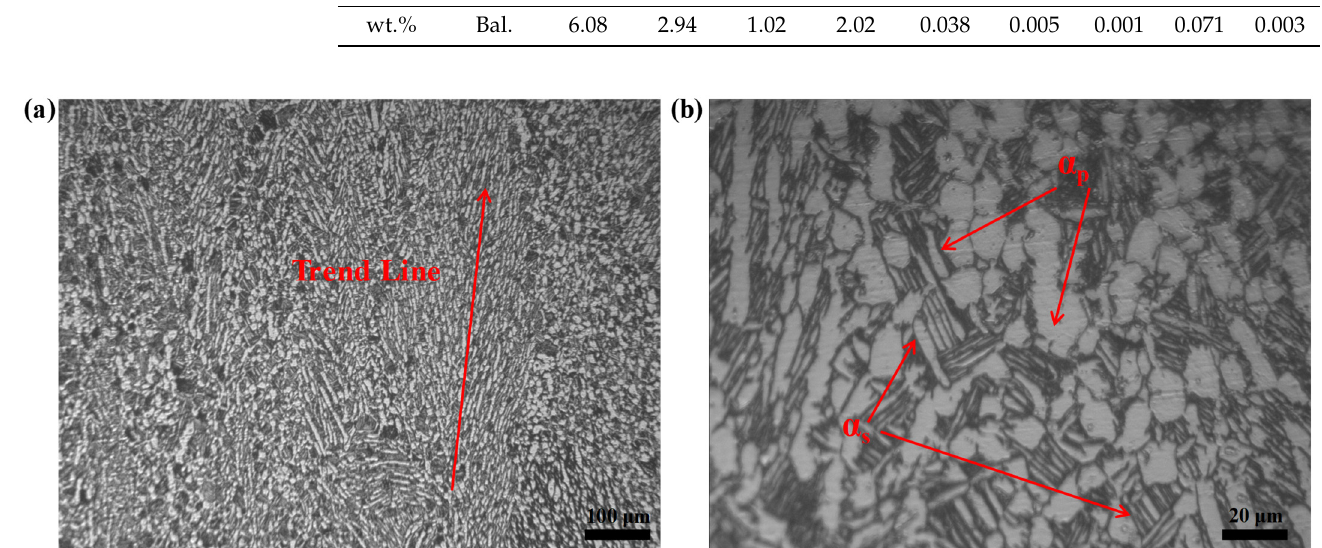
Figure 1. Initial microstructure of TA31 in the as-received condition: ( a ) 100×; ( b ) 500×. The specimens for isothermal hot compression tests are machined into a cylinder with 10 mm in diameter and 15 mm in height. These tests are conducted on a Gleeble-3500 thermo-mechanical simulator. The β -transus temperature of this alloy is 1000 ± 7 °C. The deformation temperatures are 850, 900, 940, 980, and 1050 °C. The strain rates are 0.01, 0.1, 1.0, and 10 s − 1 . The schematic illustration of the isothermal compression process is shown in Figure 2. All specimens are heated to the targeted temperature and held for 3 min to obtain a uniform temperature distribution. The height reduction of the compression tests is 60%, and argon protection is used to avoid the effect of air. The true stress–strain curves are recorded automatically in the hot compression process.